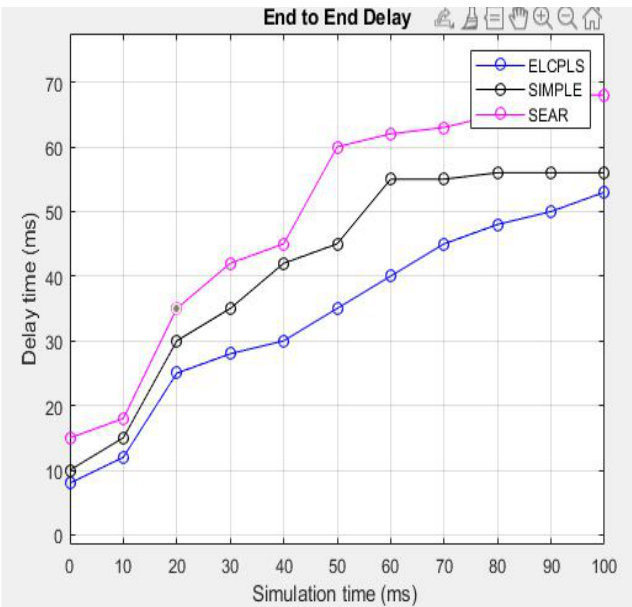
Figure 15. End to End Delay in WBAN